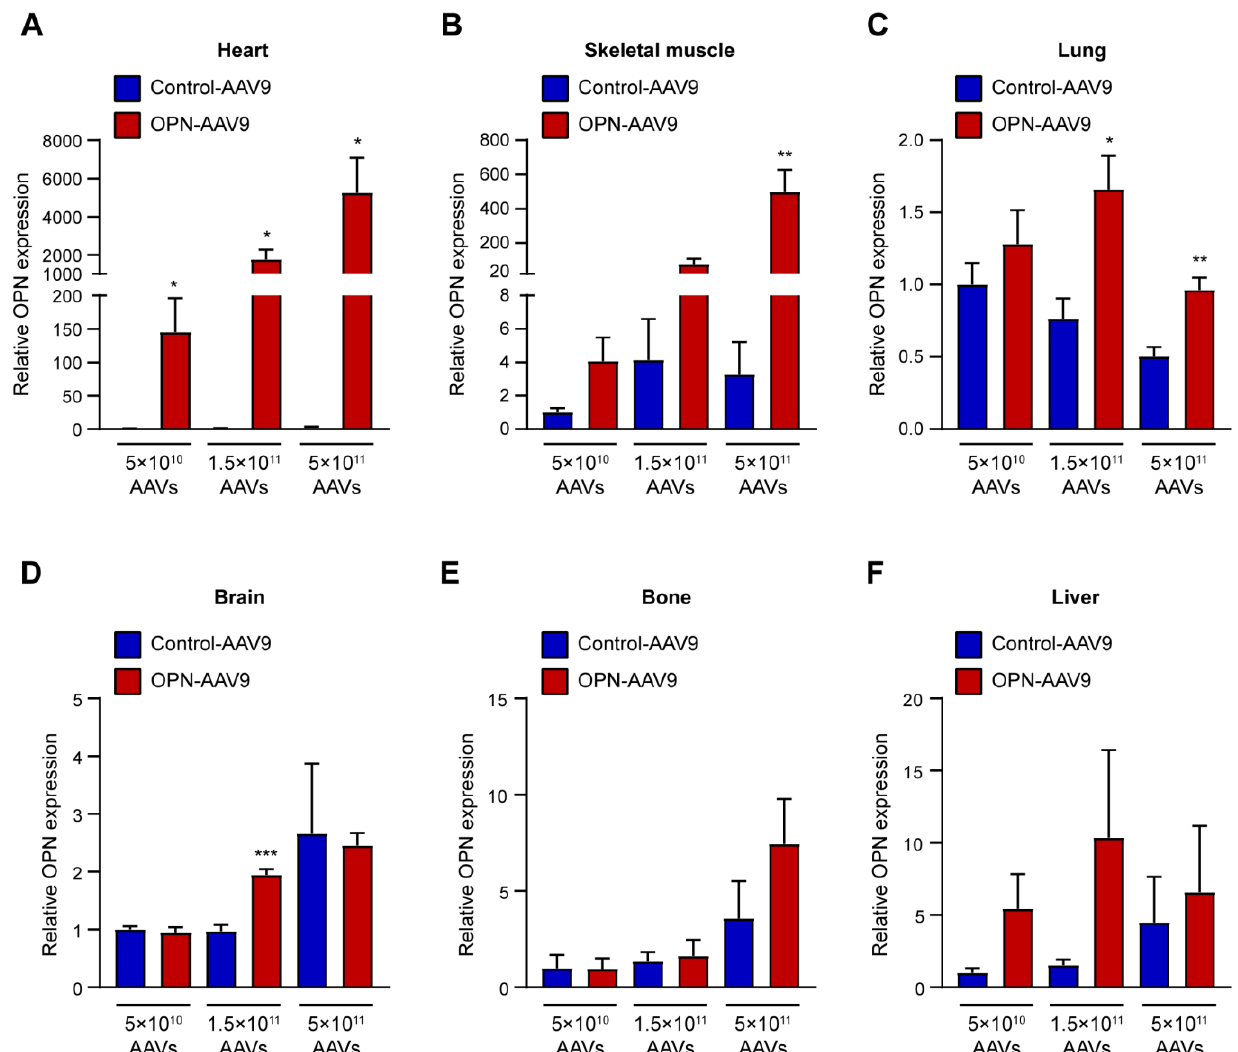
Figure 2. OPN expression in different tissues of transduced animals. ( A – F ) C57BL/6 mice were injected i.v. with empty adeno-associated viral vectors (Control-AAV9) or osteopontin expressing adenoviral vectors (OPN-AAV9) at titres of 5 × 10 10 , 1.5 × 10 11 and 5 × 10 11 viral particles per mouse. At the end point of the experiment, RNA was isolated from various organs, including skeletal muscle ( A ), heart ( B ), lung ( C ), brain ( D ), bone ( E ) and liver ( F ), and the expression levels of osteopontin were assessed using qPCR. For each titre the control and OPN groups were compared using Student’s t -test; n = 4 for all groups. * p < 0.05, ** p < 0.01, *** p < 0.001.